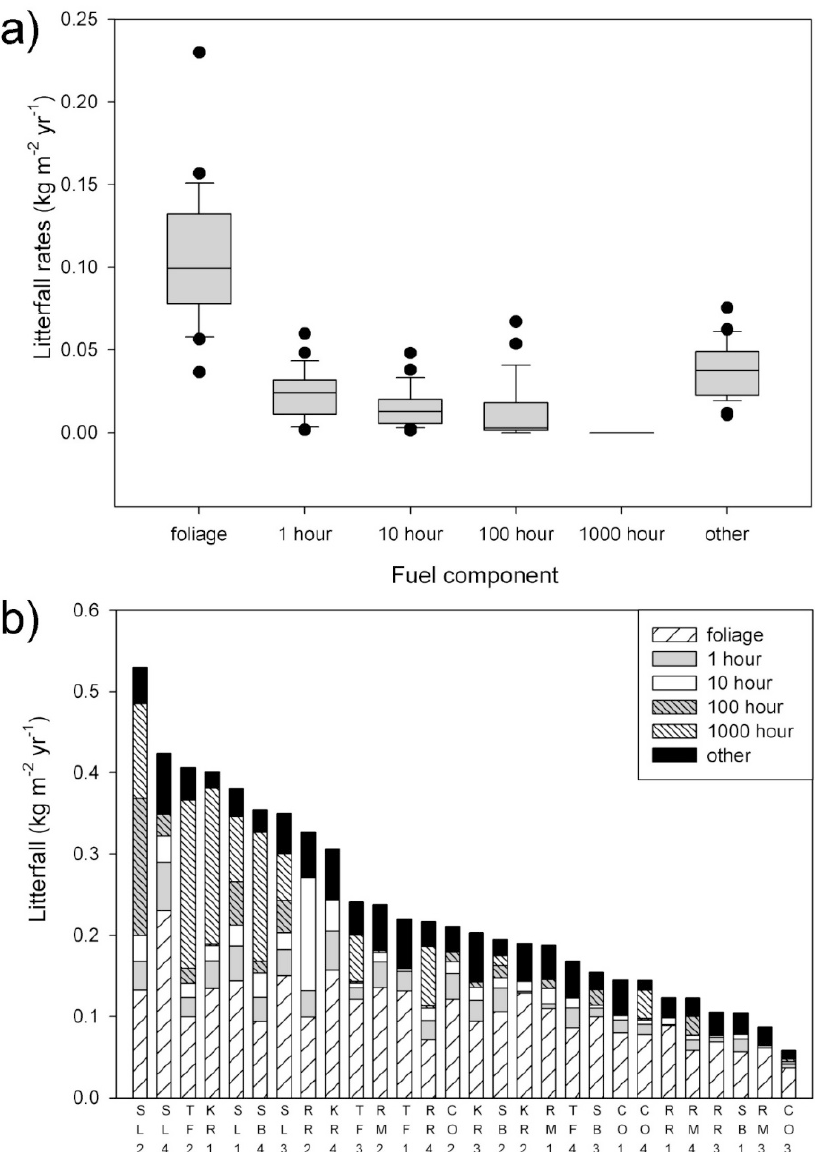
Figure 5. The amount of fuel deposited each year (litterfall) by ( a ) fuel component and ( b ) the 28 sites in the Keane [31] study. Site descriptions ID numbers on the X axis can be found in Keane [31]. Sites are arranged in order of productivity from highest to lowest.